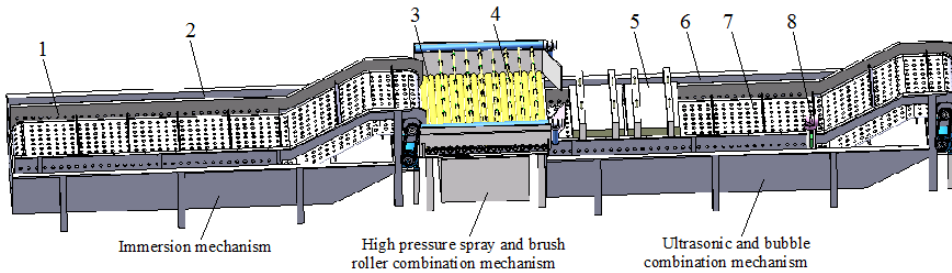
Figure 4. Constructional features and operating principle of wet cleaning equipment. 1. Conveying net chain of immersion mechanism; 2. Immersion tank; 3. Short filament brush roller; 4. High pressure spray assembly; 5. Ultrasonic vibration plate; 6. Cleaning tank; 7. Conveying net chain of ultrasonic and bubble combination mechanism; 8. Bubble spray tube assembly.